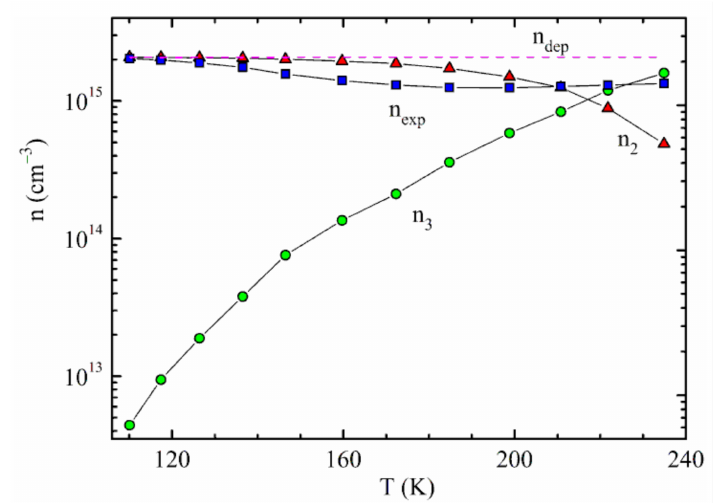
Figure 4. Temperature dependences of the experimental and calculated (2D and 3D) concentrations. n dep is the concentration of